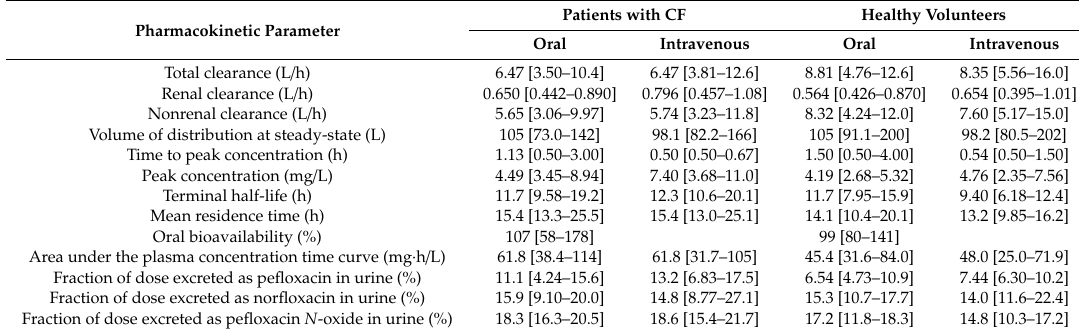
Table 2. Pharmacokinetic parameters for oral and intravenous pefloxacin in patients with CF and healthy volunteers from non-compartmental analysis (data shown as median